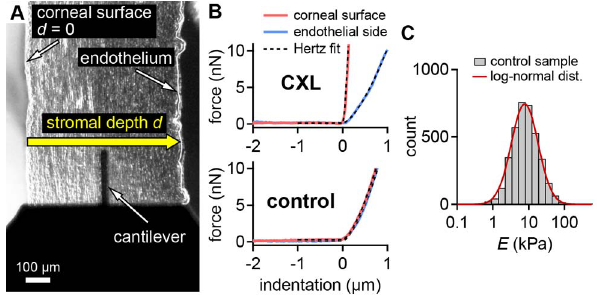
Figure 2. AFM-based creation of stromal YM profiles. A ) Optical image of a cross-linked cornea section in the AFM setup. Force- indentation-curves were recorded across the stroma at an increasing stromal depth d . B ) Representative force-indentation-curves at the corneal surface and at the endothelial side of CXL and control samples. A larger slope in the region of positive indentations represents a larger YM of the sample at the measured location. C ) Representative stromal distribution of the local YM in non-cross-linked control samples, gained from force-indentation measurements across the stroma as described in A). The local YM follows a log-normal distribution.